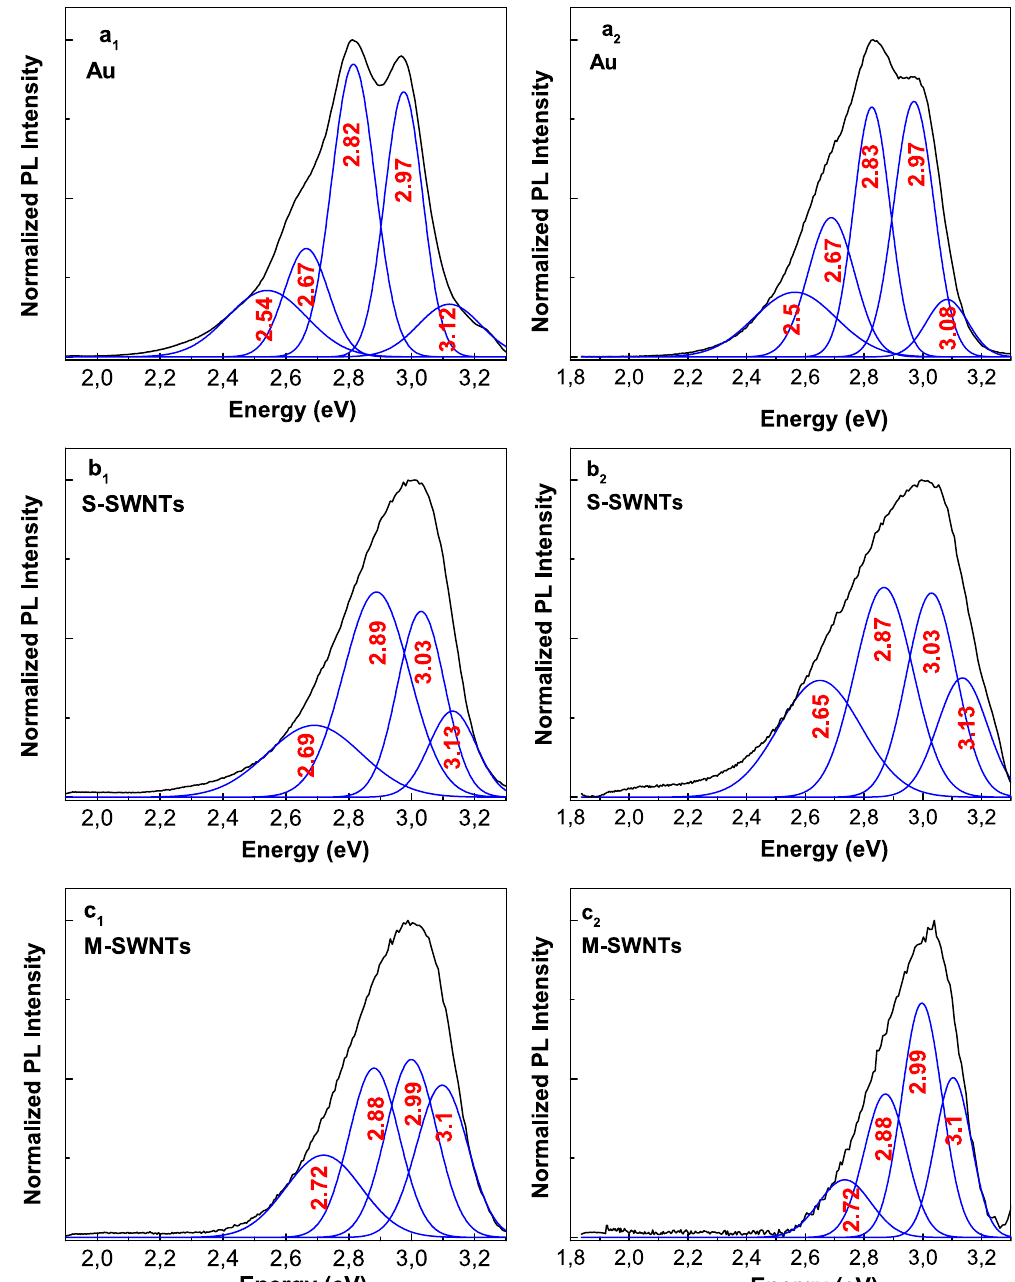
Figure 5. The de-convolution of normalized PL spectra of the samples of PANI doped with HSO 4 − and Cl − ions, respectively, electrosynthesized during the 30 CVs onto the blank Au electrode ( a 1 and a 2 ) and the Au plates covered with films of S-SWNTs ( b 1 and b 2 ) and M- SWNTs ( c 1 and c 2 ), after the interaction with the 1 M NH 4 OH